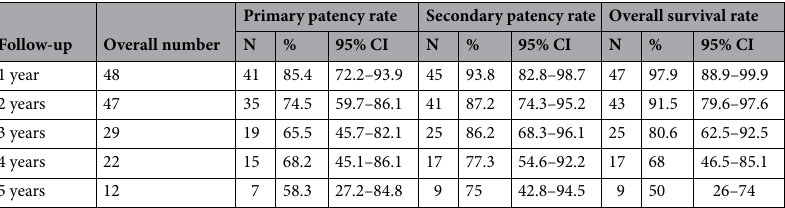
Table 2. Descriptive analysis of primary and secondary patency rates at different time points over 5 years. CI, confidence